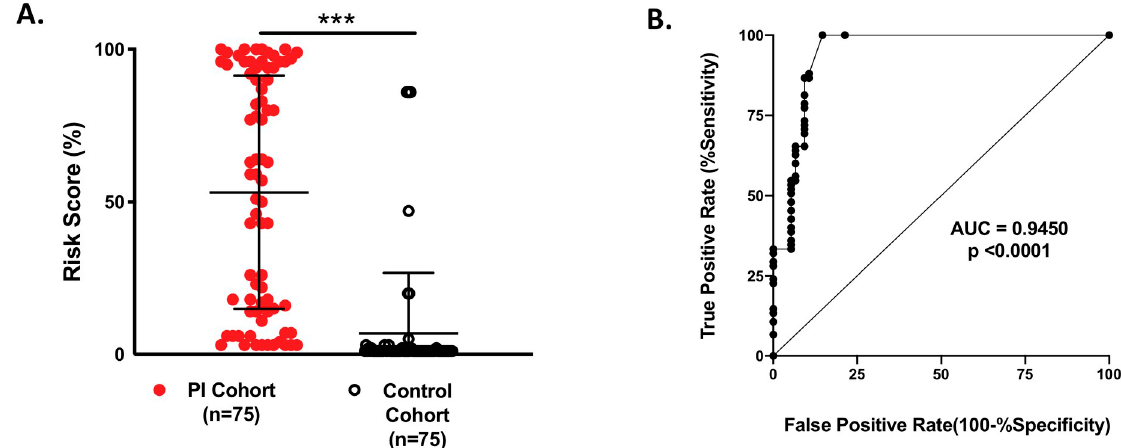
Fig 3. Network validation. Validity testing of our BN for individual patients from the PI and Control cohorts. A . Mean risk scores between the two populations were significantly different (53% vs. 7%; p < 0.000001). B . Network performance as calculated by AUROC (Area under Receiver Operator Characteristic Curve) where an AUROC of 1.0 represents the ability of a model to discriminate between classes 100% of the time.